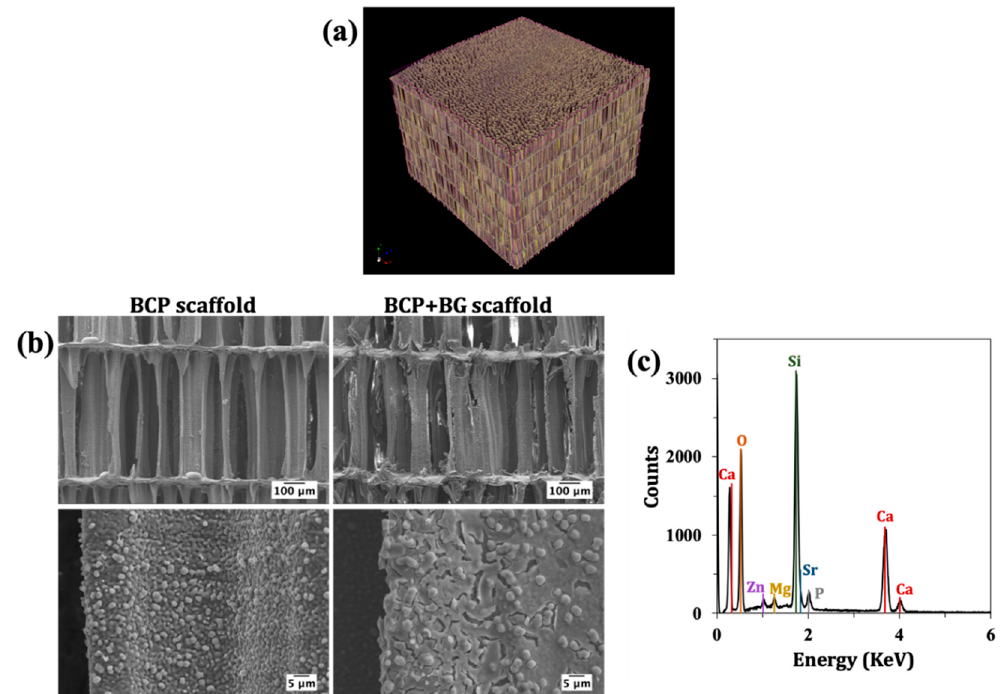
Figure 3. Microstructural and chemical features of the scaffolds: (a) µ-CT image showing the microstructure of raw cuttlefish bone (CB) highlighting its interconnected porosity; (b) SEM micrographs of uncoated and coated BCP scaffolds; (c) energy dispersive spectroscopy (EDS) analysis of the sol-gel derived BG coating.